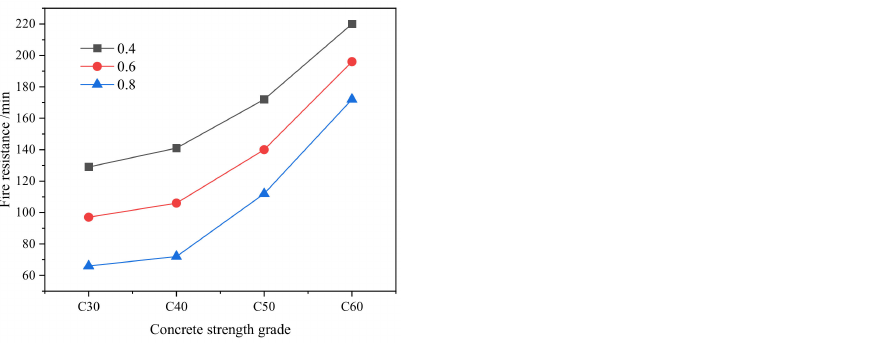
Figure 14. Curves of the effect of different concrete strength grades on the fire resistance of